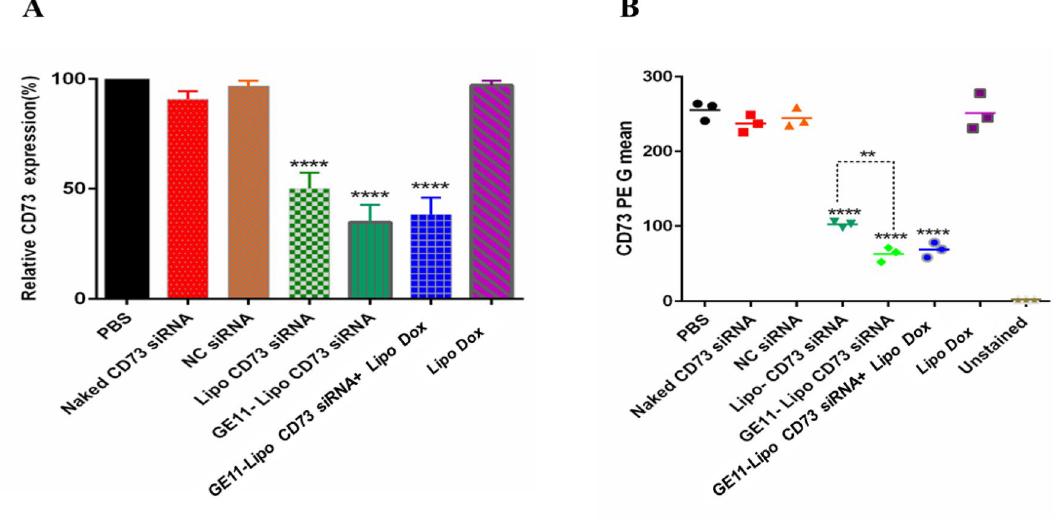
Figure 7. Efficacy of liposomal formulations on both CD73 gene expression and CD73 ectonucleotidase level by RT-PCR and flow cytometry, respectively, in the tumor tissue of mice inoculated with 4T1 cell line. ( A ) The result of RT-PCR showed that the targeted form of liposome containing CD73 siRNA (GE11-Lipo CD73 siRNA) alone and in combination with Liposomal doxorubicin could efficiently reduce the expression of CD73 gene (****: P value < 0.0001). ( B ) Decreased fluorescence intensity indicates decreased CD73 ectonucleotidase level. Histogram shows the intensity of PE fluorescence in the treatment groups. CD73 PE G mean stands for geometric mean of fluorescence intensity of CD73 PE. Data are shown as the mean ± SD (n = 3). Statistically significant differences are shown as follow: ** P < 0.01 and **** P < 0.0001.